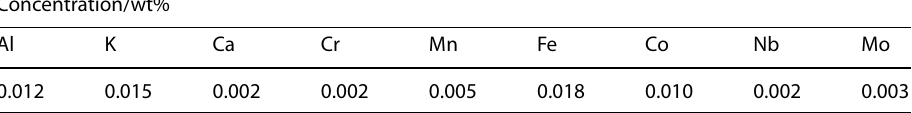
Concentration/wt%